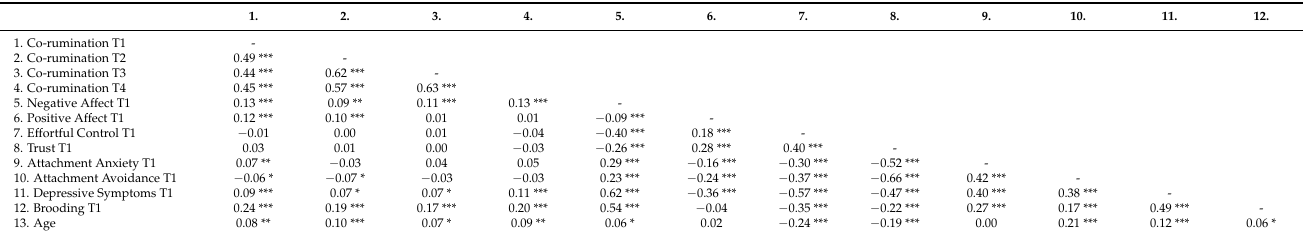
Table 2. Intercorrelations among all variables at